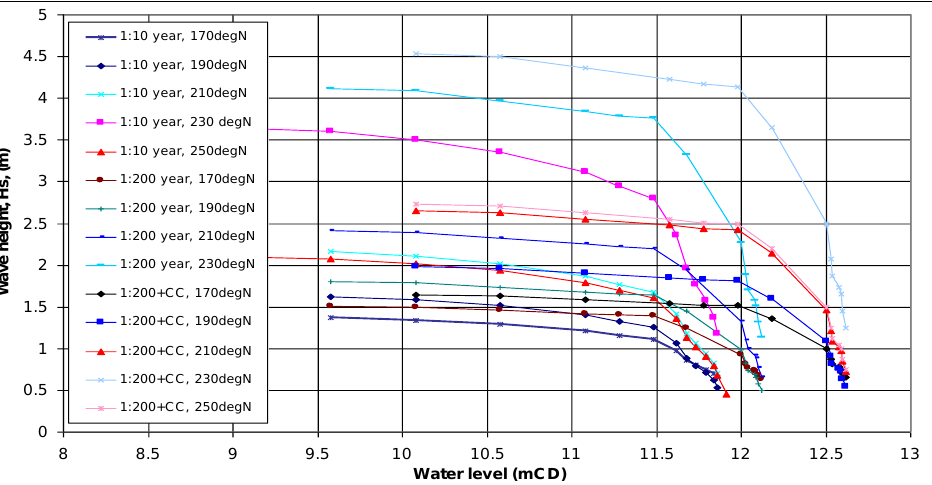
Figure 12. Refined JPA conditions for Position C3.